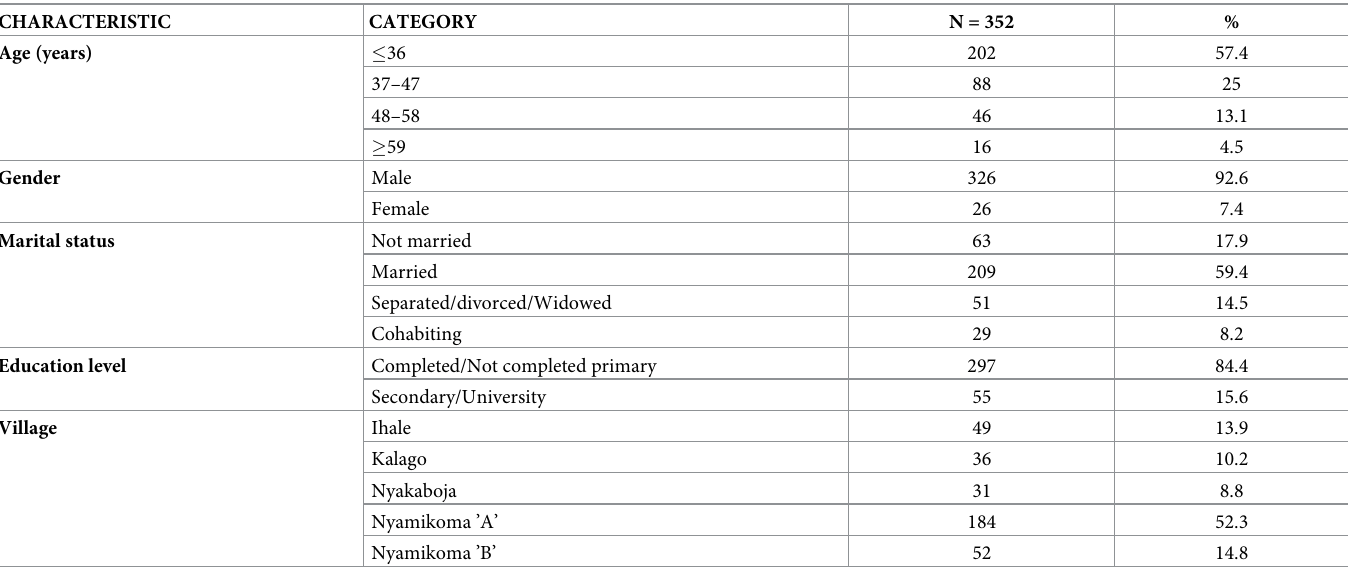
Table 1. Socio-demographic information of fishermen participated in the study. CHARACTERISTIC